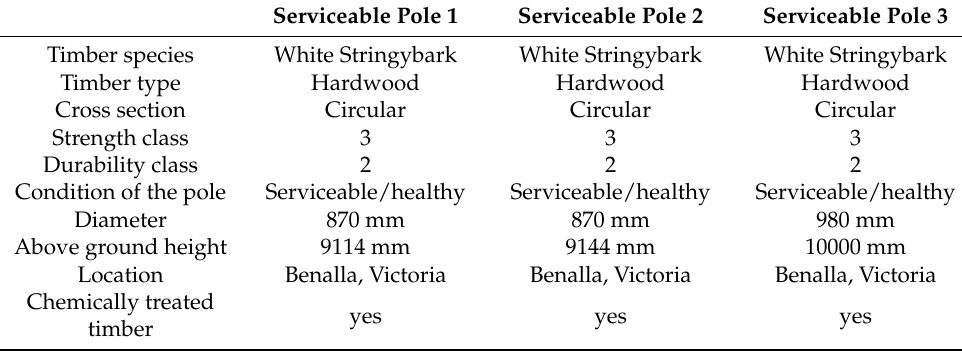
Table 3. Detail of three in-situ serviceable timber